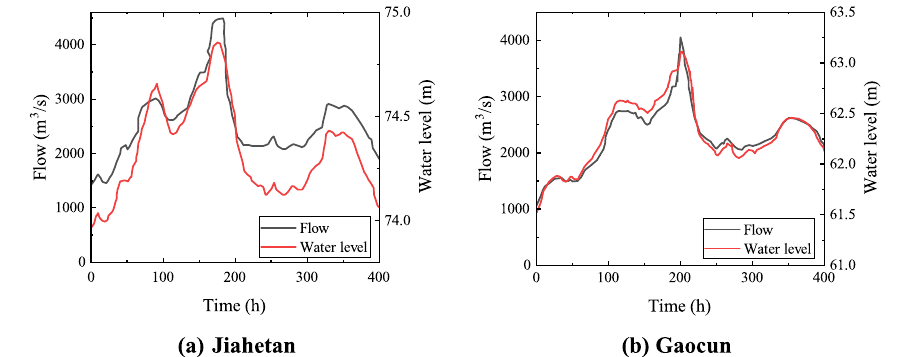
Fig. 3 “92.8” flood process. a Jiahetan. b